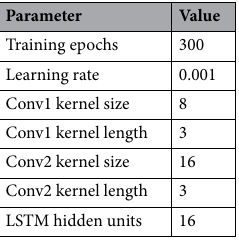
Table 1. Network parameter settings.